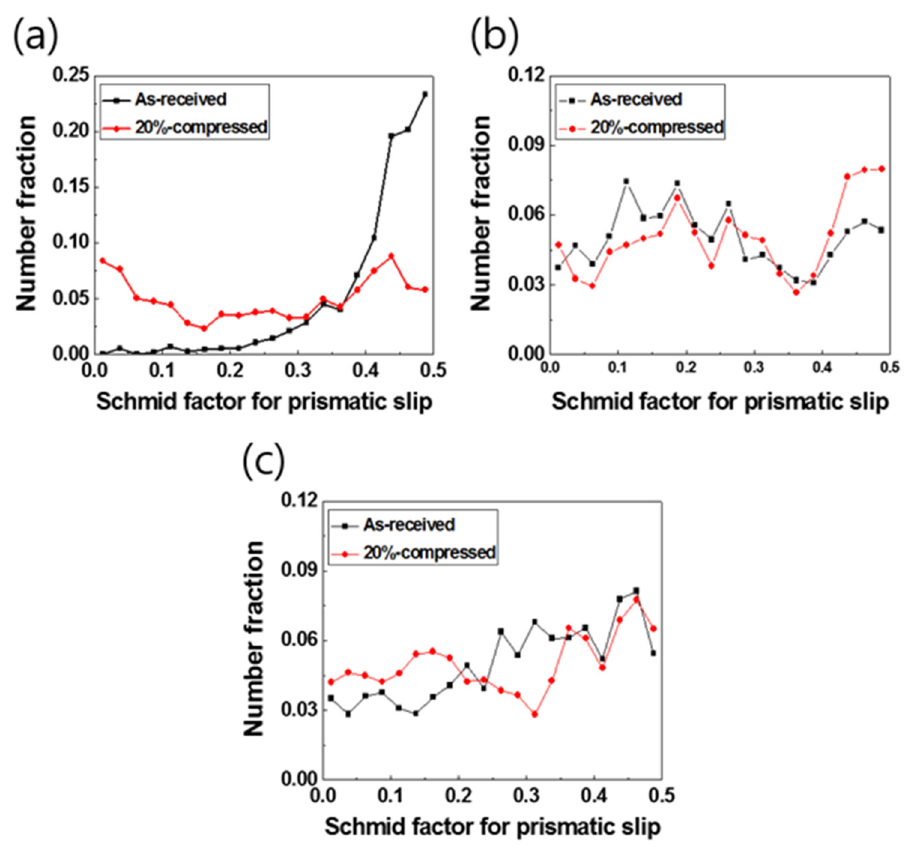
Figure 4. Distribution of the SF (Schmid factor) values for prismatic slip before and after applying a compressive strain of 0.2: ( a ) RD, ( b ) ND, and ( c ) TD.